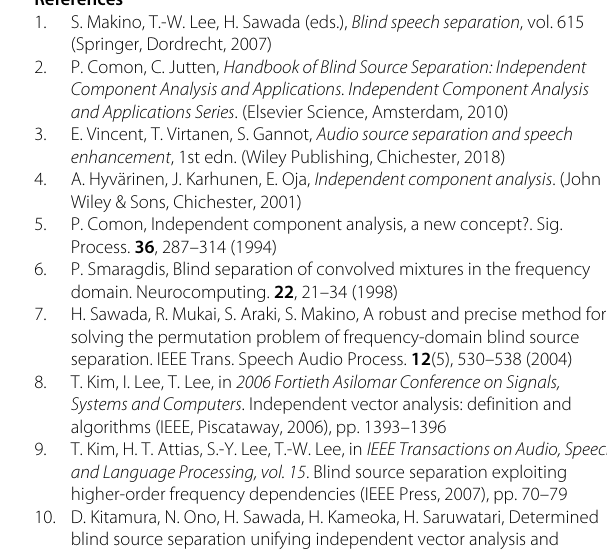
For the future, the proposed methods provide us with alternatives to the conventional approaches that adapt to the source movements through application of static mix- ing models on short time-intervals. Their other abilities, for example, the adaptability to high speed speaker move- ments and the robustness against a highly reverberant and noisy environment, pose an interesting topic for future research